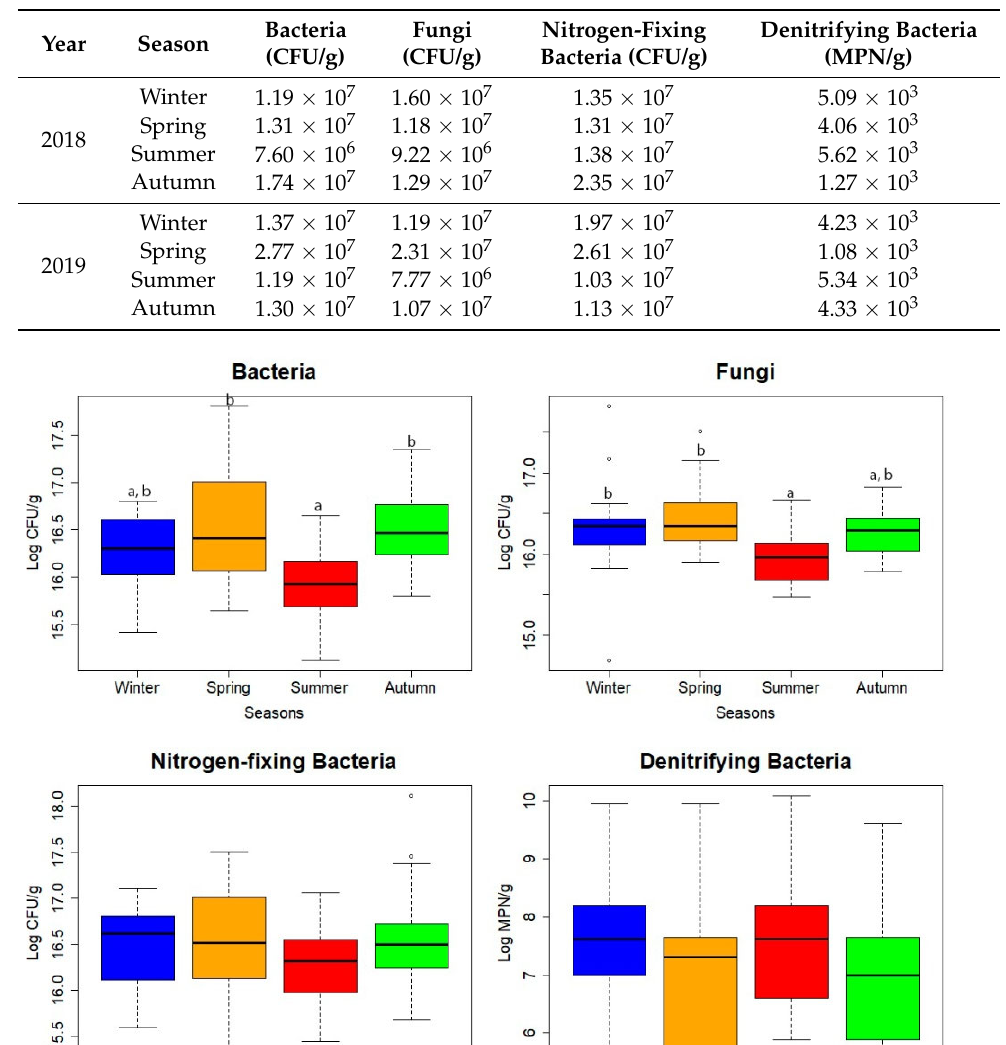
Table 3. Average quantification of microorganism’s colonies among seasons in Quinta das Vinhas , total bacteria and fungi, denitrifying, and nitrogen-fixing bacteria, for 2 years.